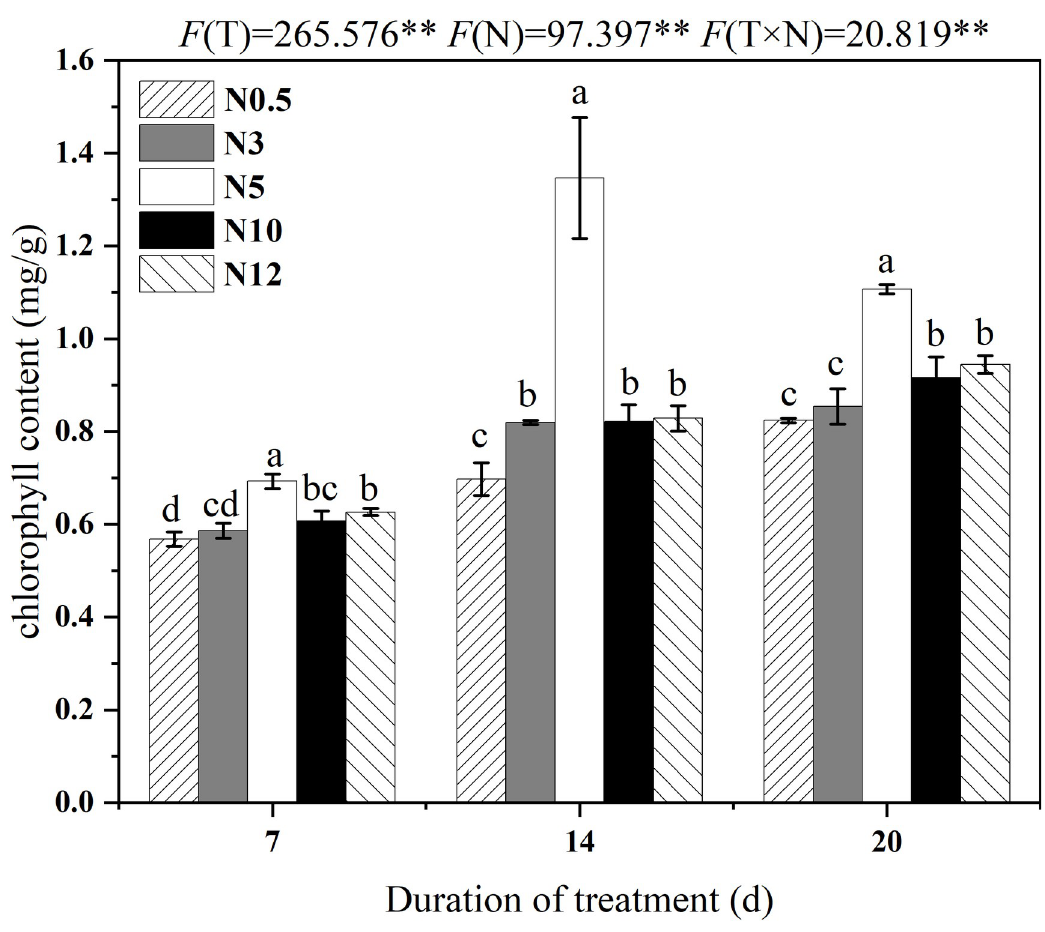
Fig 2. Changes of chlorophyll content in sugar beet seedlings under low and high N stresses. Note: control: N5; low N: N0.5 and N3; high N: N10 and N12; Different letters indicated significant difference among treatments (P < 0.05) in the same day, F(T) indicated the F value for duration of treatment, F(N) indicated the F value of N concentration, and F(T × N) denoted F-value for the interaction of stress time and intensity. � and �� indicated significant (P < 0. 05) and (P < 0. 01), respectively. The same